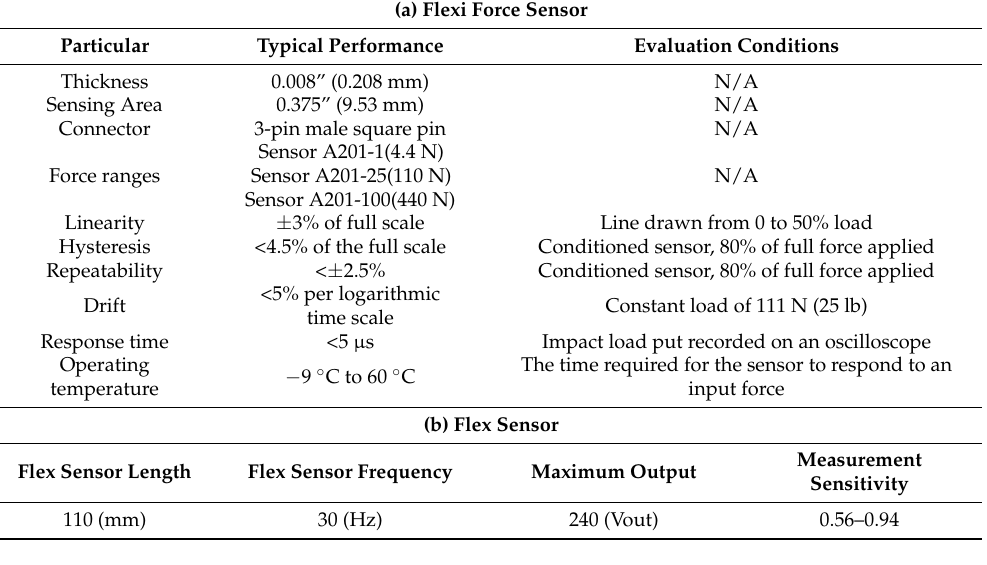
Table 1. Typical specifications of the Flexi force sensor, flex sensor, PVC, and sports shoe.